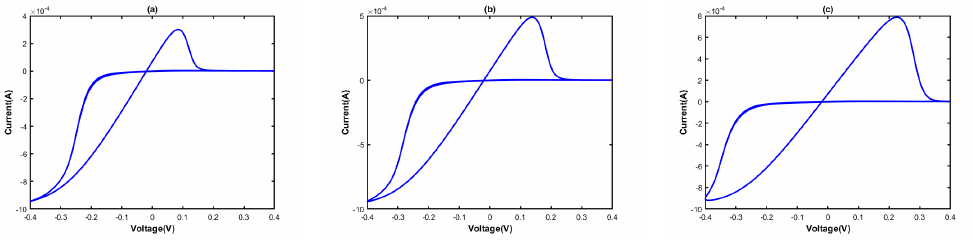
Figure 8. Voltage − current curves of varying capacitance, for 45 nm: ( a ) 33 nF, ( b ) 51 nF, and ( c ) 100 nF.